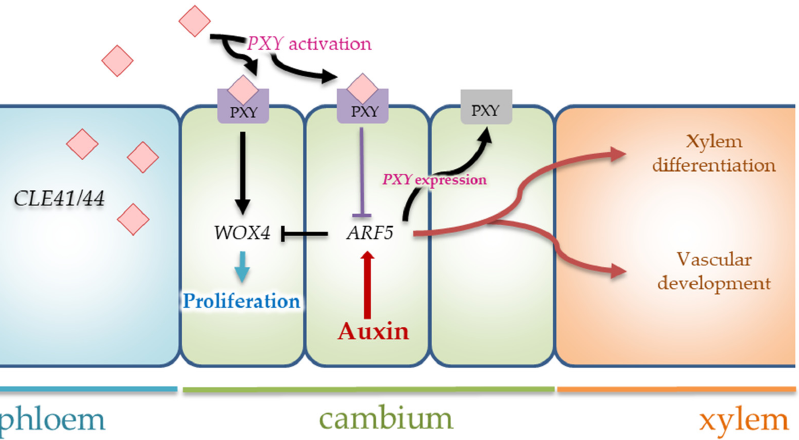
Figure 8. Model showing interactions between TDIF(CLE41)/TDR(PXY) signaling and auxin signal- ing for proliferation/differentiation cambium derivatives. The explanations are in the text.